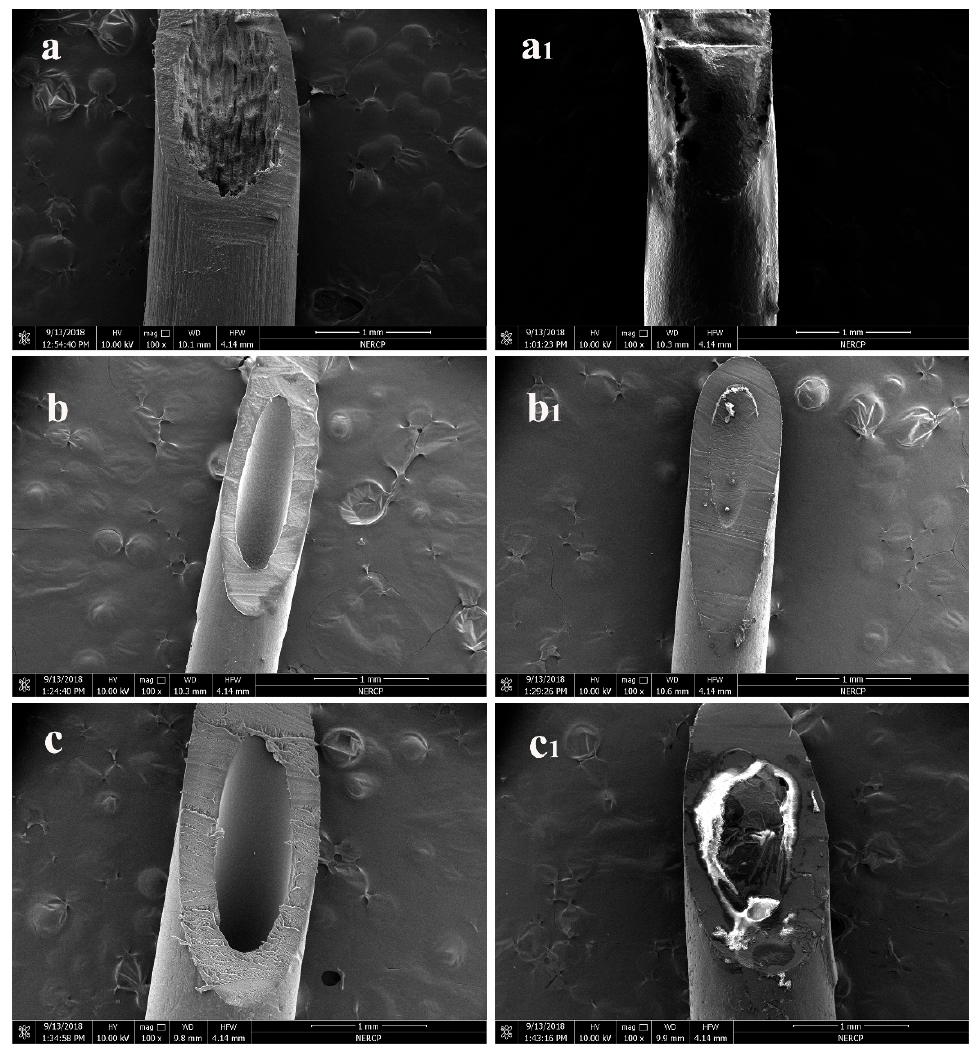
Figure 4. Encapsulation effect of columnar hollow portion; ( a ) is PVDF membrane; ( b ) is PP membrane; ( c ) is PSF membrane; ( a ), ( b ), ( c ) are before paraffin encapsulation; ( a 1 ), ( b 1 ), ( c 1 ) are after paraffin encapsulation.